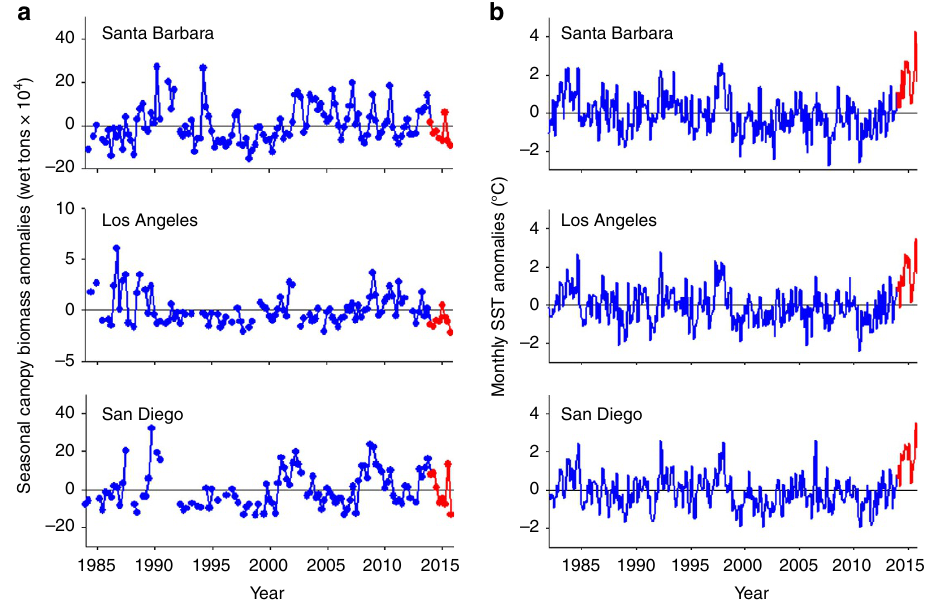
Figure 4 | Regional trends in giant kelp biomass and SST. ( a ) Seasonal canopy anomalies of giant kelp biomass estimated from Landsat 5 Thematic Mapper and Landsat 7 Enhanced Thematic Mapper for 1984–2015. ( b ) Monthly SSTanomalies from National Climatic Data Center Optimal Interpolation Sea Surface Temperature data for 1984–2015. Data are shown for the counties of Santa Barbara, Los Angeles and San Diego, which span the 450km coastline of southern California and B 2 (cid:2) latitude (34.5N in Santa Barbara and 32.2N in San Diego). Data for 2014–2015 are shown in